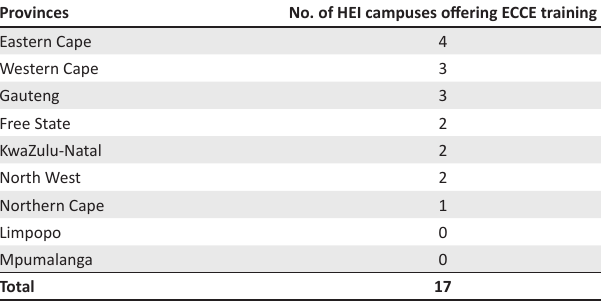
TABLE 3: Higher education institutions (universities or campuses) offering early childhood care and education, by province.